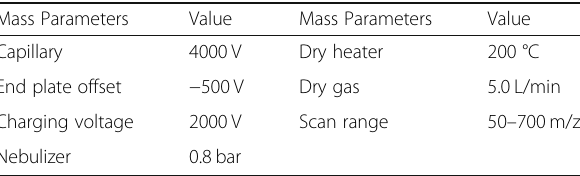
Table 1 Optimize mass spectrum parameters for bromophenol- thiosemicarbazone hybrid